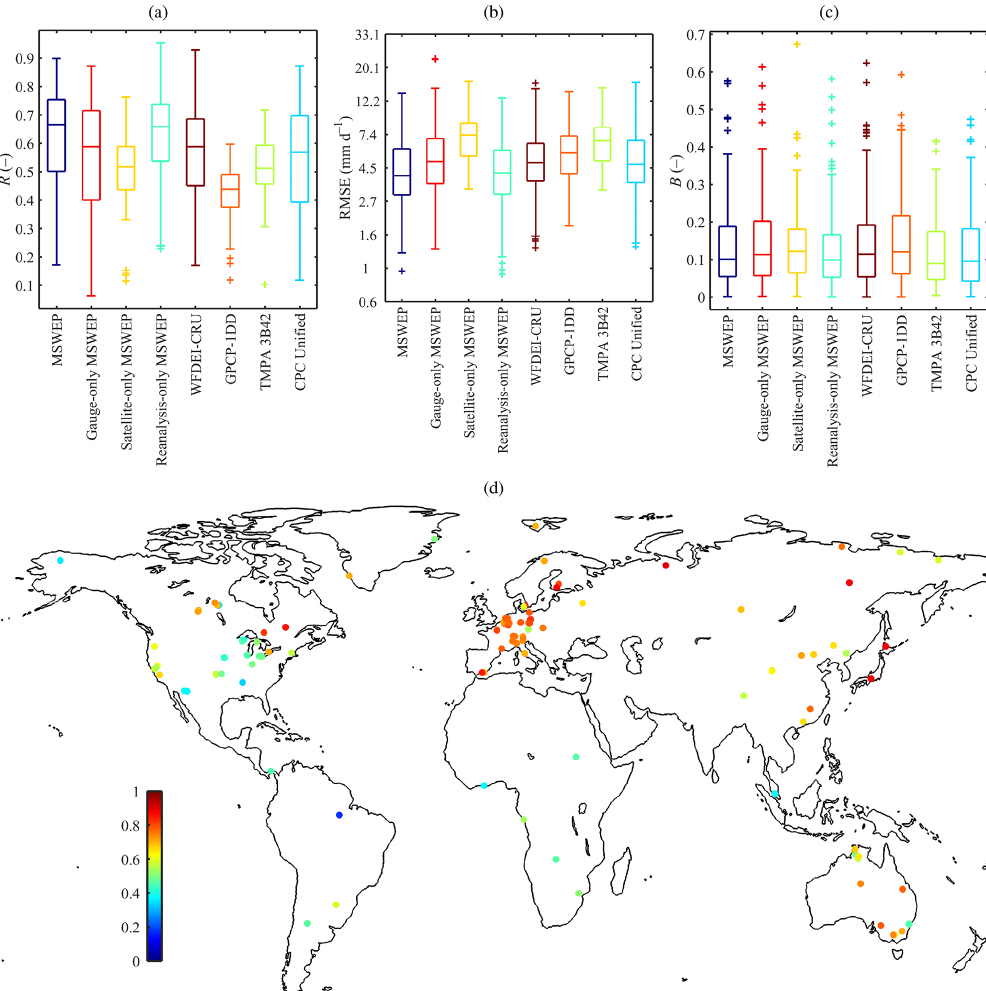
Figure 7. Box plots of the distribution of (a) daily correlation ( R ), (b) root mean square error (RMSE), and (c) absolute bias ( B ) values com- puted between observed and estimated P at the 125 FLUXNET sites. Note that for the satellite-only MSWEP only the 113 stations located at < 60 ◦ N/S were used, while for TMPA 3B42 only the 87 stations located at < 50 ◦ N/S were used. The locations of the 125 FLUXNET stations and the R values obtained by MSWEP are shown in (d) . The list of stations is provided in the